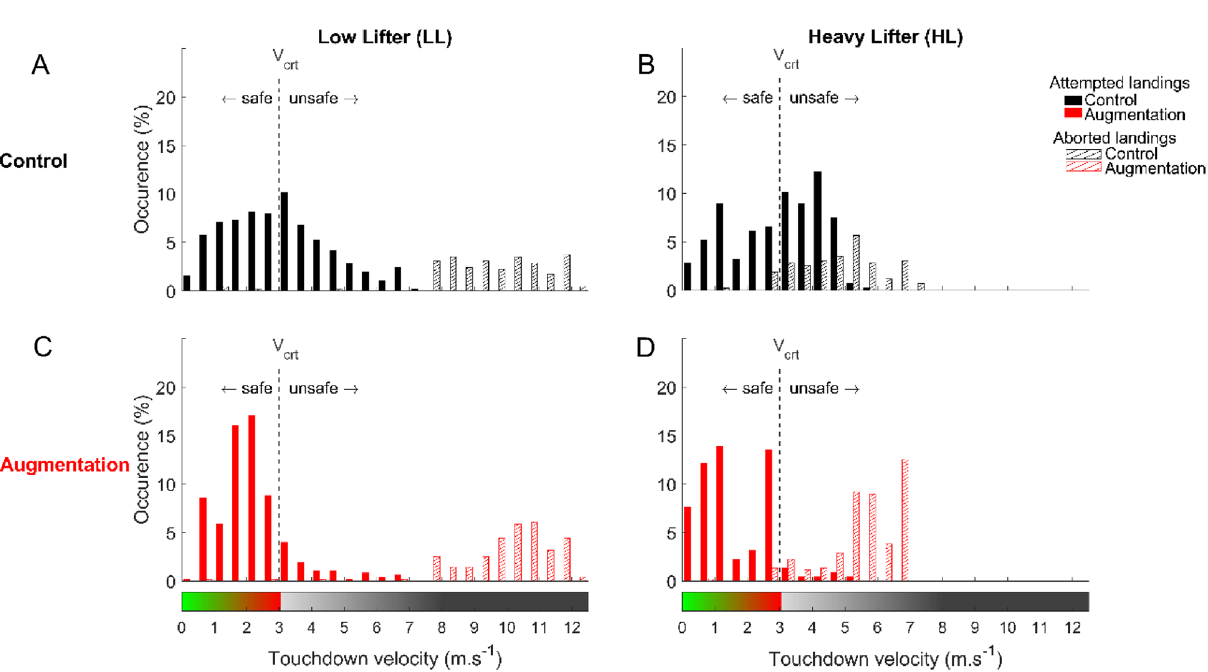
attempt td ) and predicted